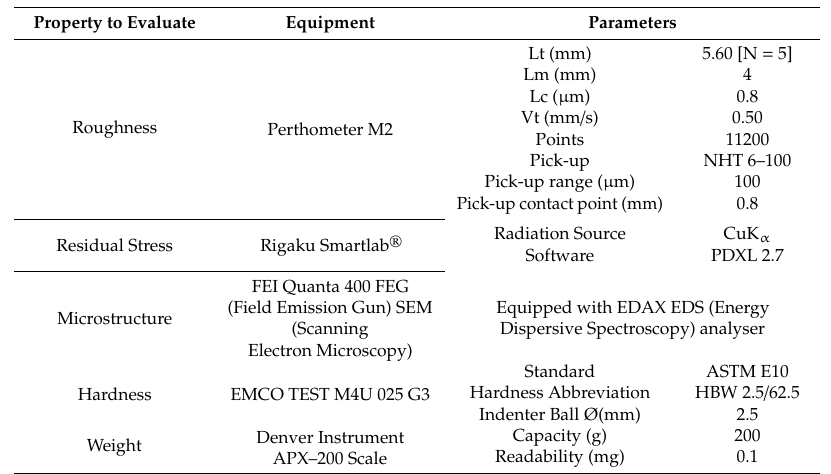
Table 3. Sample evaluation equipment and parameters.